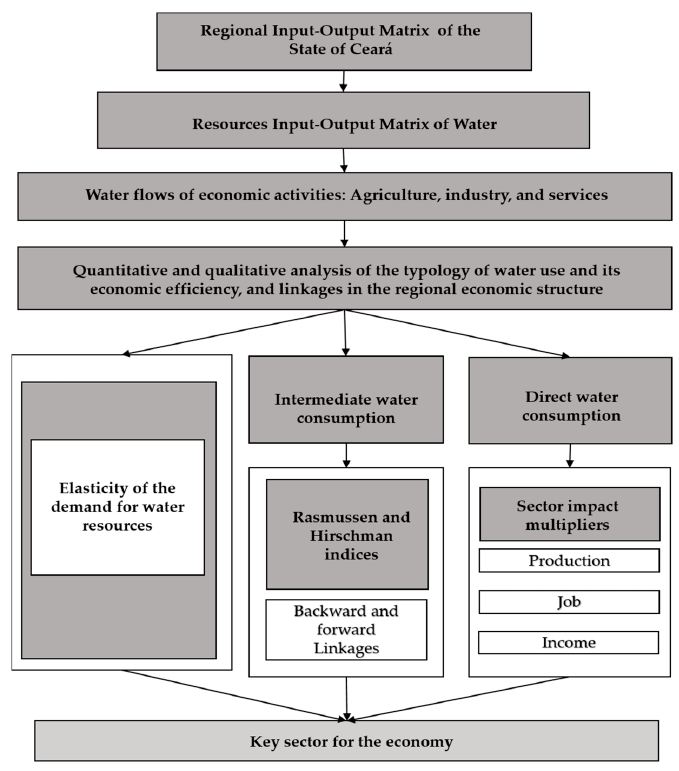
Figure 2. Methodological strategy.